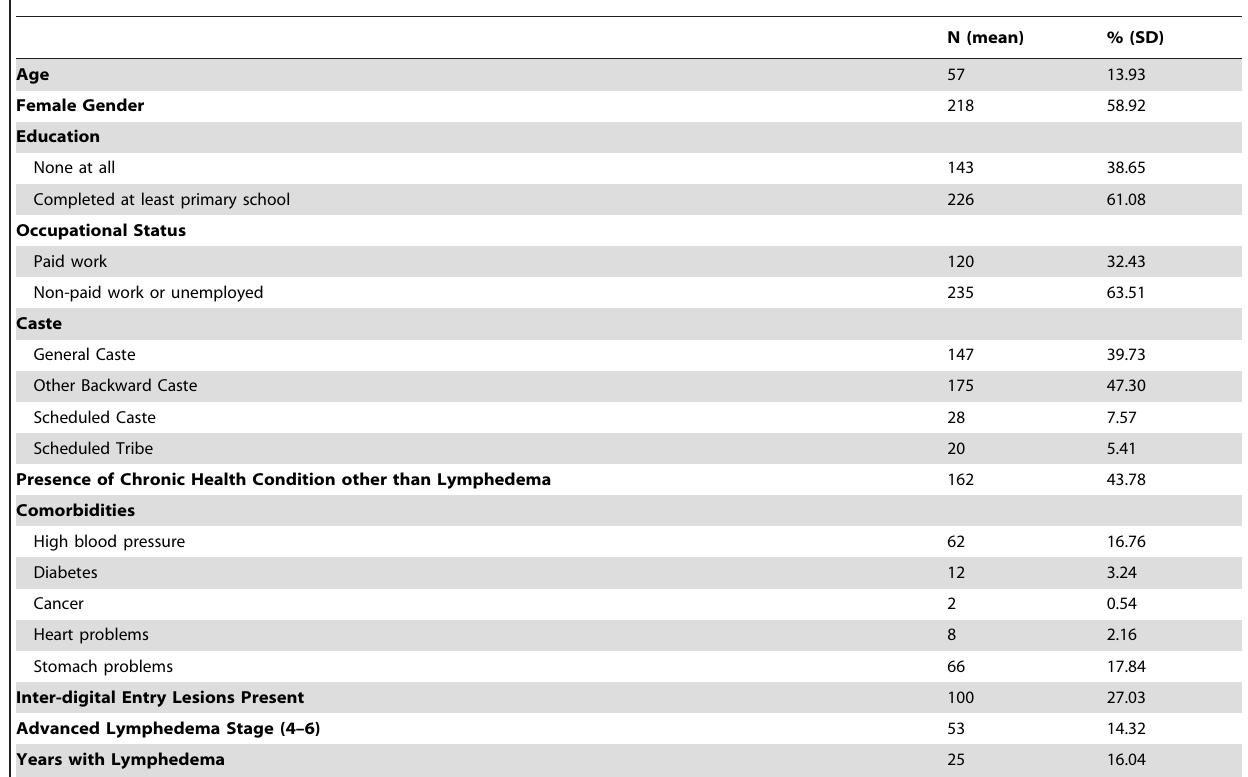
Table 1. Baseline characteristics of patients enrolled in a lymphedema management program, Khurda District, Odisha State, India, July